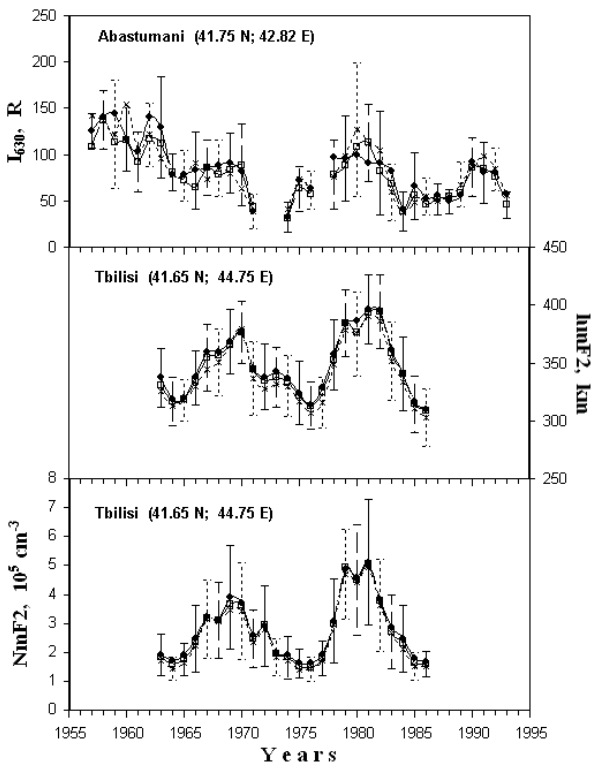
Fig. 1. Variations of the annual mean value of the red 630 nm line total nightglow intensity I 630 (upper panel), the ionosphere F2 layer peak height hm F2 (middle panel) and its electron den- sity Nm F2 (bottom panel) for three different pre-midnight periods (21:00–22:00LT – full line and circles, 22:00–23:00LT – thin line and diamonds and 23:00–24:00LT – dashed line and “x”) observed at Abastumani in 1957–1993 and Tbilisi in 1963–1986. Vertical lines are one sigma error bars.